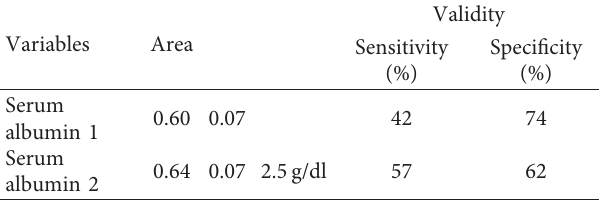
Table 4: Performance of serum albumin 1 and serum albumin 2 as predictors for the mortality in ICU patients.